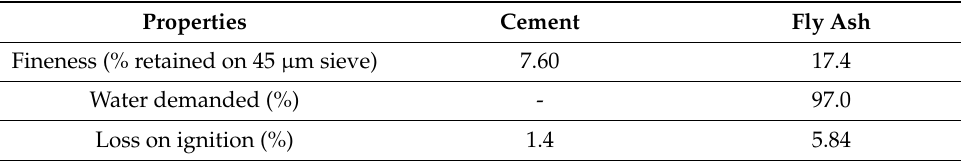
Table 2. Physical composition of cement and fly ash.